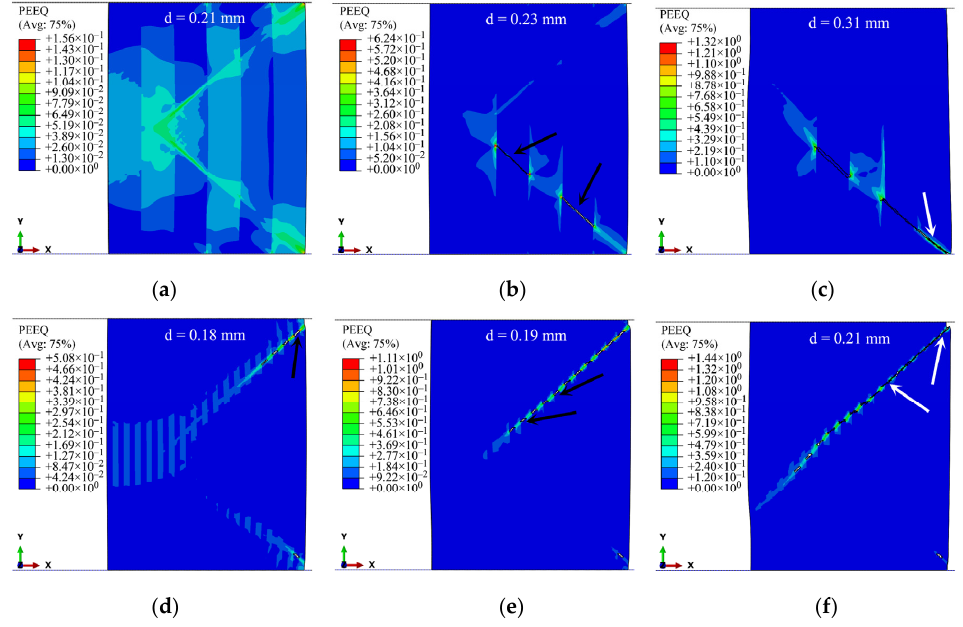
Figure 19. Sequence of crack initiation and growth in 3by3 and 18by18 models at 𝜀(cid:4662) (cid:3036) = 1 s − 1 : ( a ) for- mation of shear bands; ( b ), ( d ), ( e ) cracks form and grow in the layers of the brittle base material that are close to the outer wall; ( c ), ( f ) layers of the ductile material start to crack from the outer wall and connect the existing cracks in the brittle layers along the direction of shear bands. The stroke of top platen, d , is shown at the top of the models.